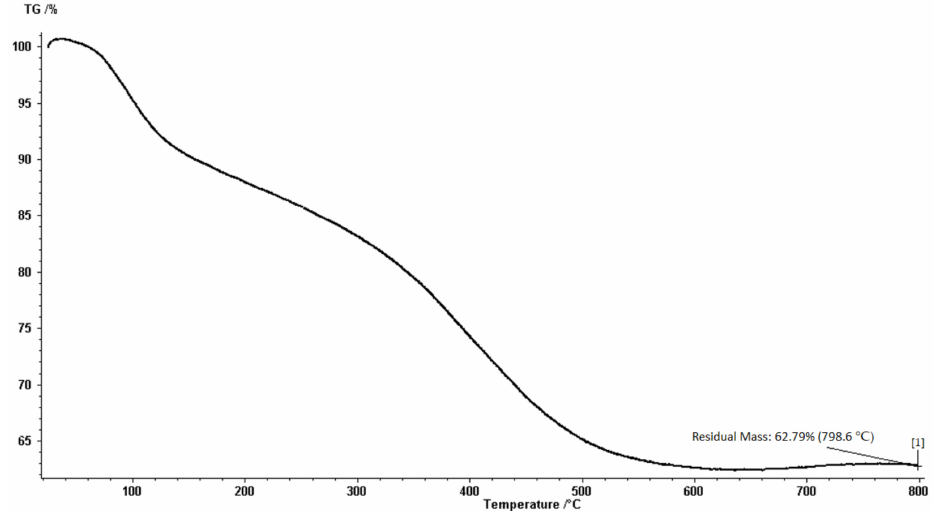
Figure 3. The thermogravimetric analysis (TGA) of the prepared